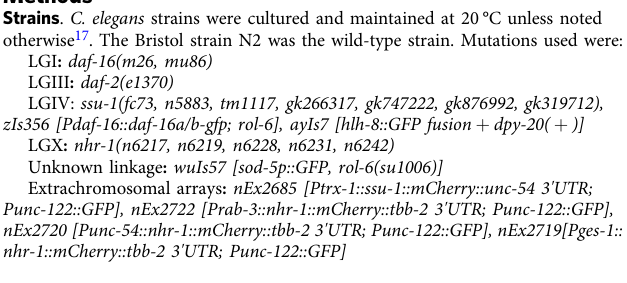
metabolism throughout metazoan (e.g., much of the insulin sig- propose that neuronal cytosolic sulfotransferase activity functions abnormalities in such signaling underlie a variety of human naling, such as obesity and type 2 diabetes.